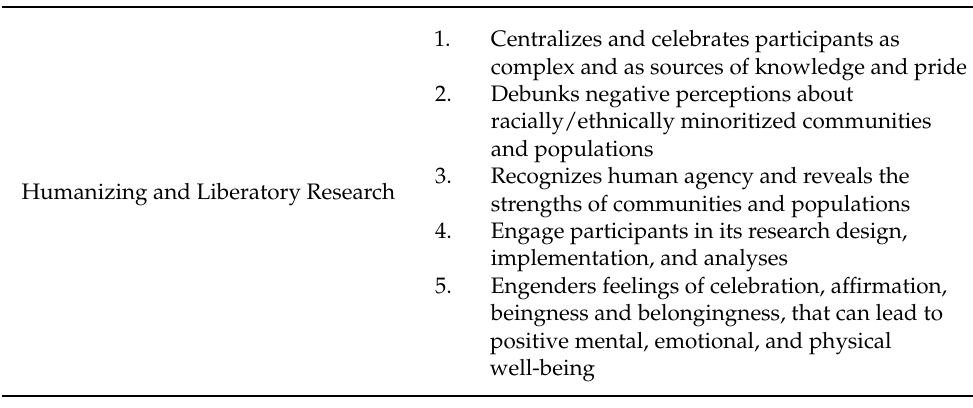
Table 2. Humanizing and Liberatory Qualitative